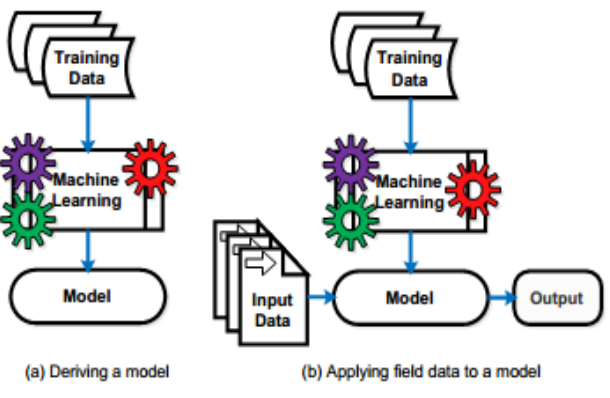
Figure 17. Machine learning